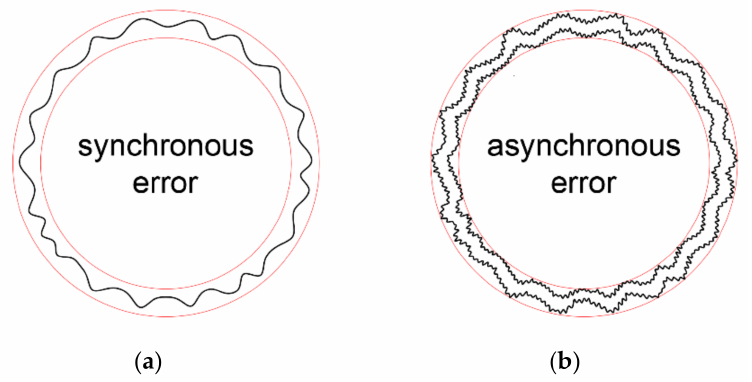
Figure 8. Radial errors in the spindle movement (measurement of multiple revolutions): ( a ) syn- chronous and ( b )